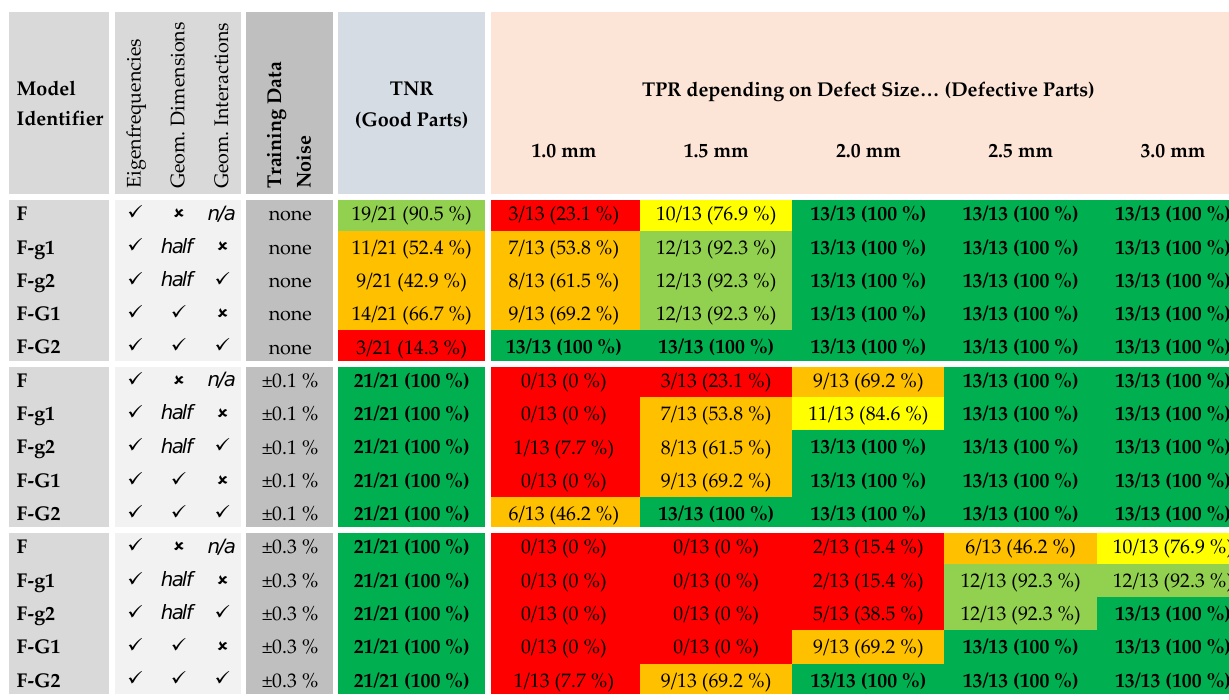
20 of 26 Figure 13. Deviations of model-like predicted eigenfrequencies of machine-made connecting rods versus their ART measured eigenfrequencies depending on part no. and quality state.